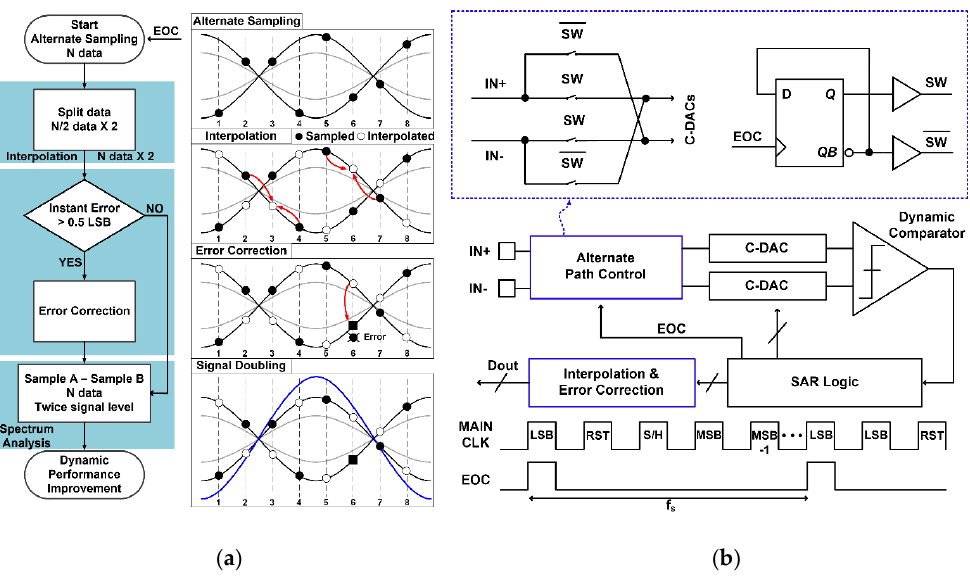
Figure 2. ( a ) Alternate-sampling error-correction scheme and ( b ) its circuit implementation.